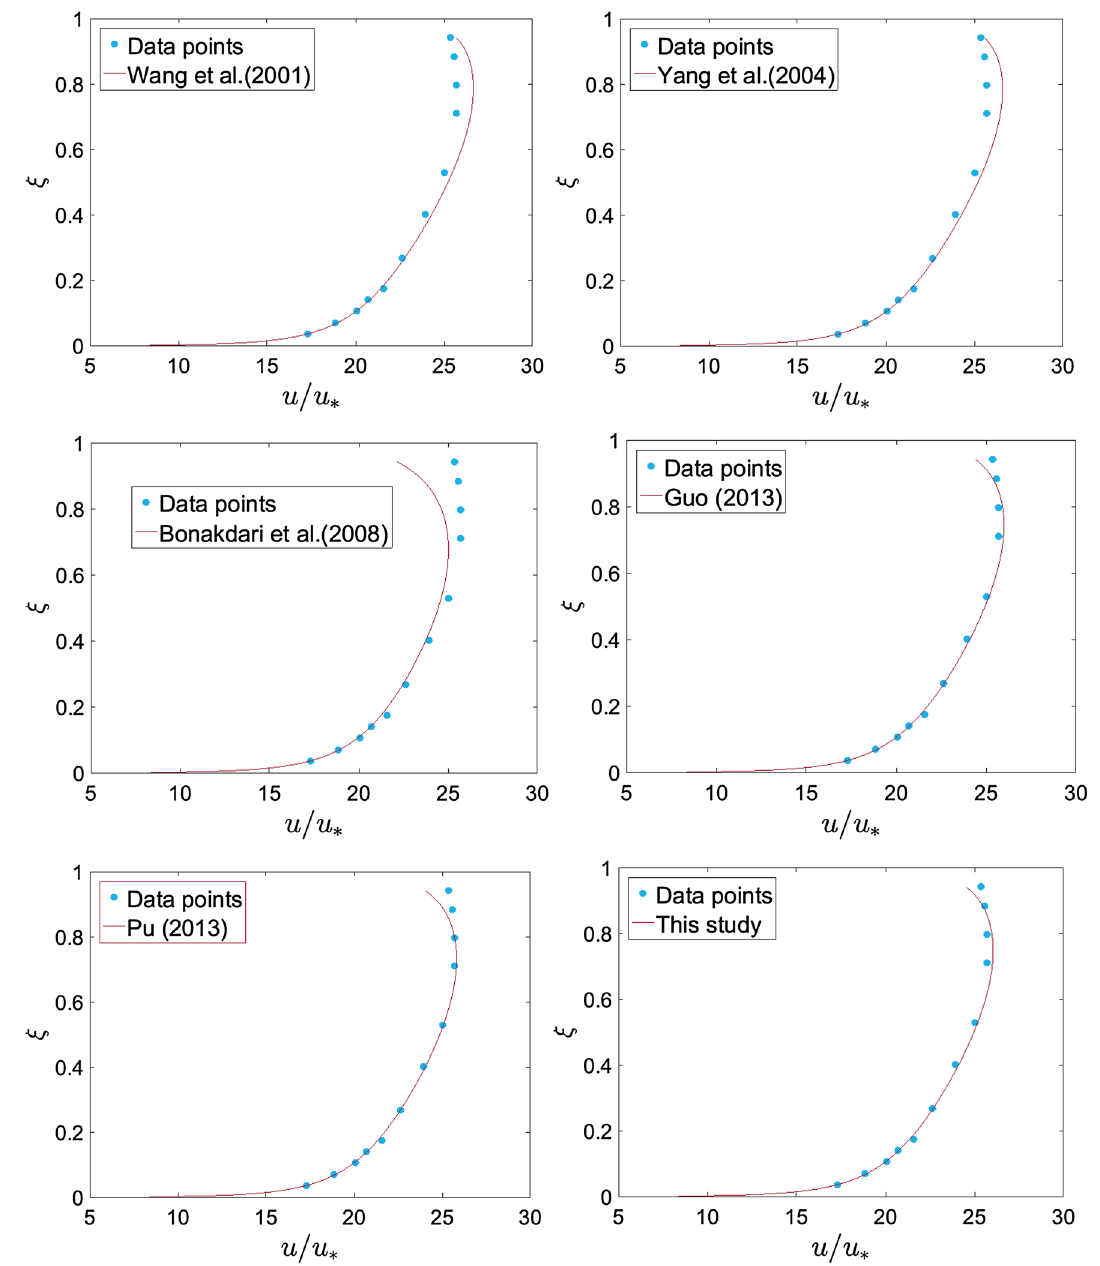
Fig. 7 Prediction of mean velocity by Eq. (14) using dip formulas Table 3 Accuracy of the model for predicting velocity profile Coleman (1986)